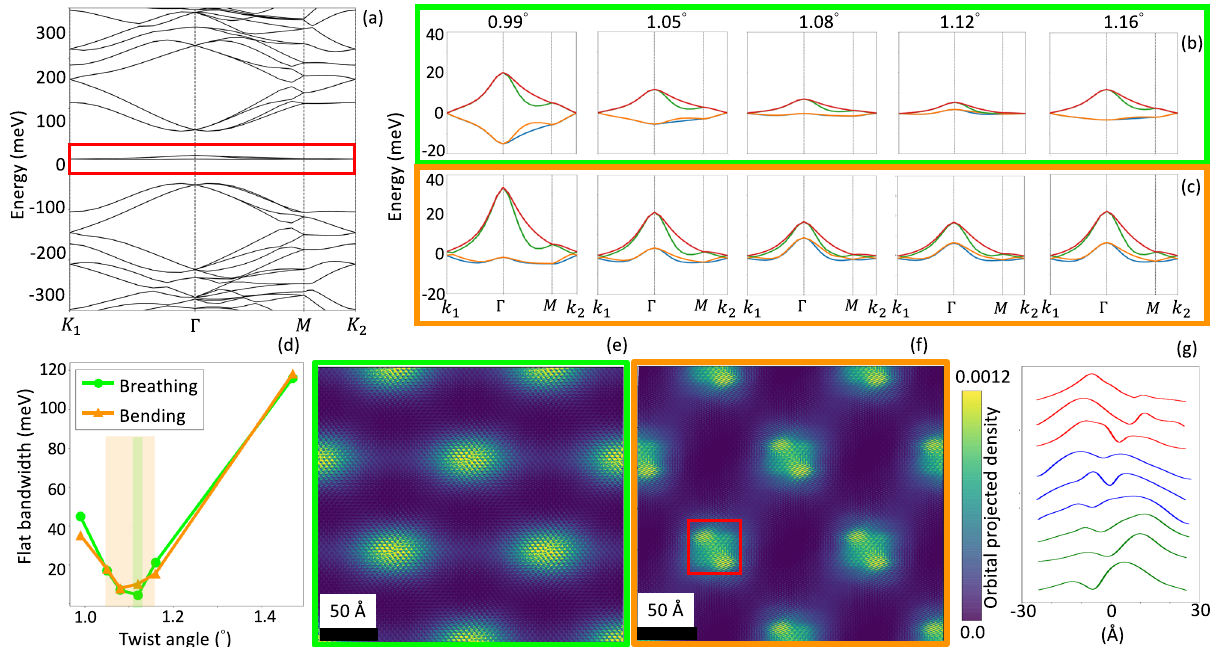
Fig. 2 Band structure and orbital projected density of twisted bilayer graphene (tBLG) near the magic-angle. a Band structure of tBLG at 1.08 ∘ showing fl at bands near the Fermi level in the breathing mode, highlighted inside the red box. b , c Magni fi ed view of the band structure near the Fermi level of tBLG at different twist angles in the breathing mode (green box) and the bending mode (orange box). Each band is denoted by separate colors. d The plot of fl at bandwidth at the Γ point as a function of twist angle. This shows a minimum fl at bandwidth at twist angle 1.12 ∘ for breathing mode and at 1.08 ∘ for bending mode. The shaded region indicates the twist angle regime where fl at bands are partially fi lled for breathing mode (Green) and bending mode (Orange). e , f The orbital projected density near the Fermi level for tBLG of twist angle 1.12 ∘ in the breathing mode and at 1.08 ∘ in the bending mode. g Spatial scan of orbital projected density along the vertical direction in the AA region (indicated by red box) showing the spectral weight transfer in the bending mode of the tBLG at 1.08 ∘ .